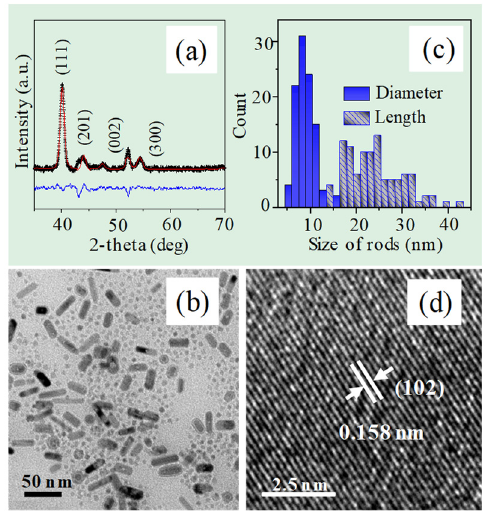
Figure 1. ( a ) XRD pattern of Fe 2 P with a Rietveld refinement fit. ( b ) TEM image of Fe 2 P NPs. ( c ) Size distribution plots of Fe 2 P NRs taken from ( b ). ( d ) HR-TEM image taken from an individual Fe 2 P NP.